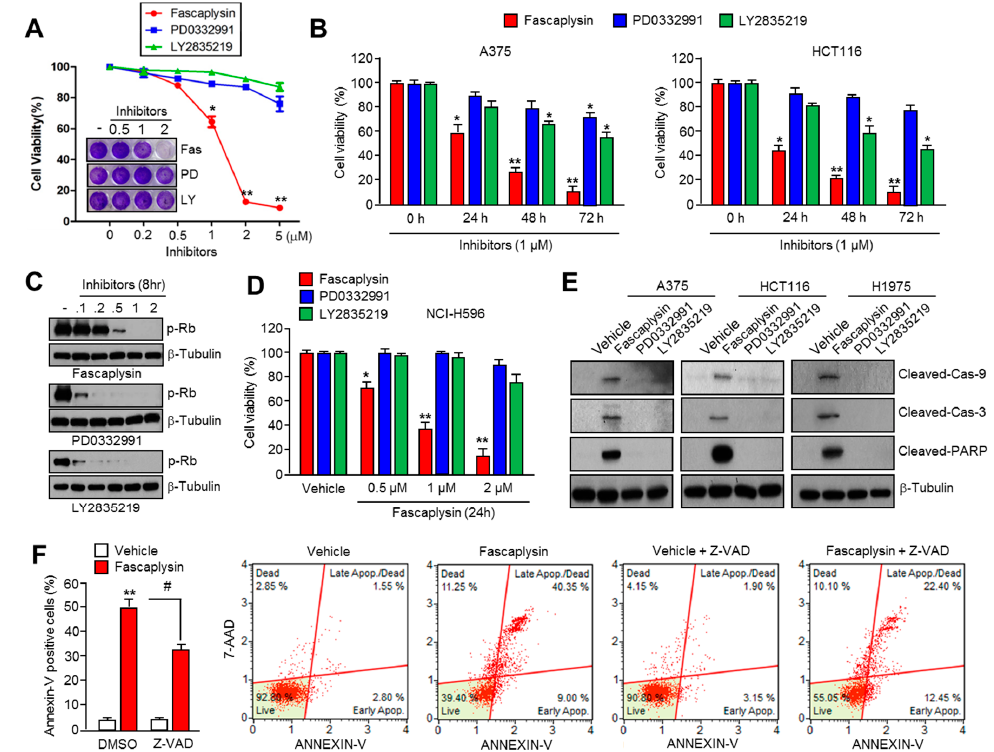
Figure 1. Fascaplysin rapidly induced apoptosis independently of the CDK4- retinoblastoma (CDK4-RB) axis. ( A ) The growth inhibition by CDK4 inhibitors, such as fascaplysin, PD0332991, or LY2835219 in A375 malignant melanoma cells for 24 h. Crystal violet staining images are